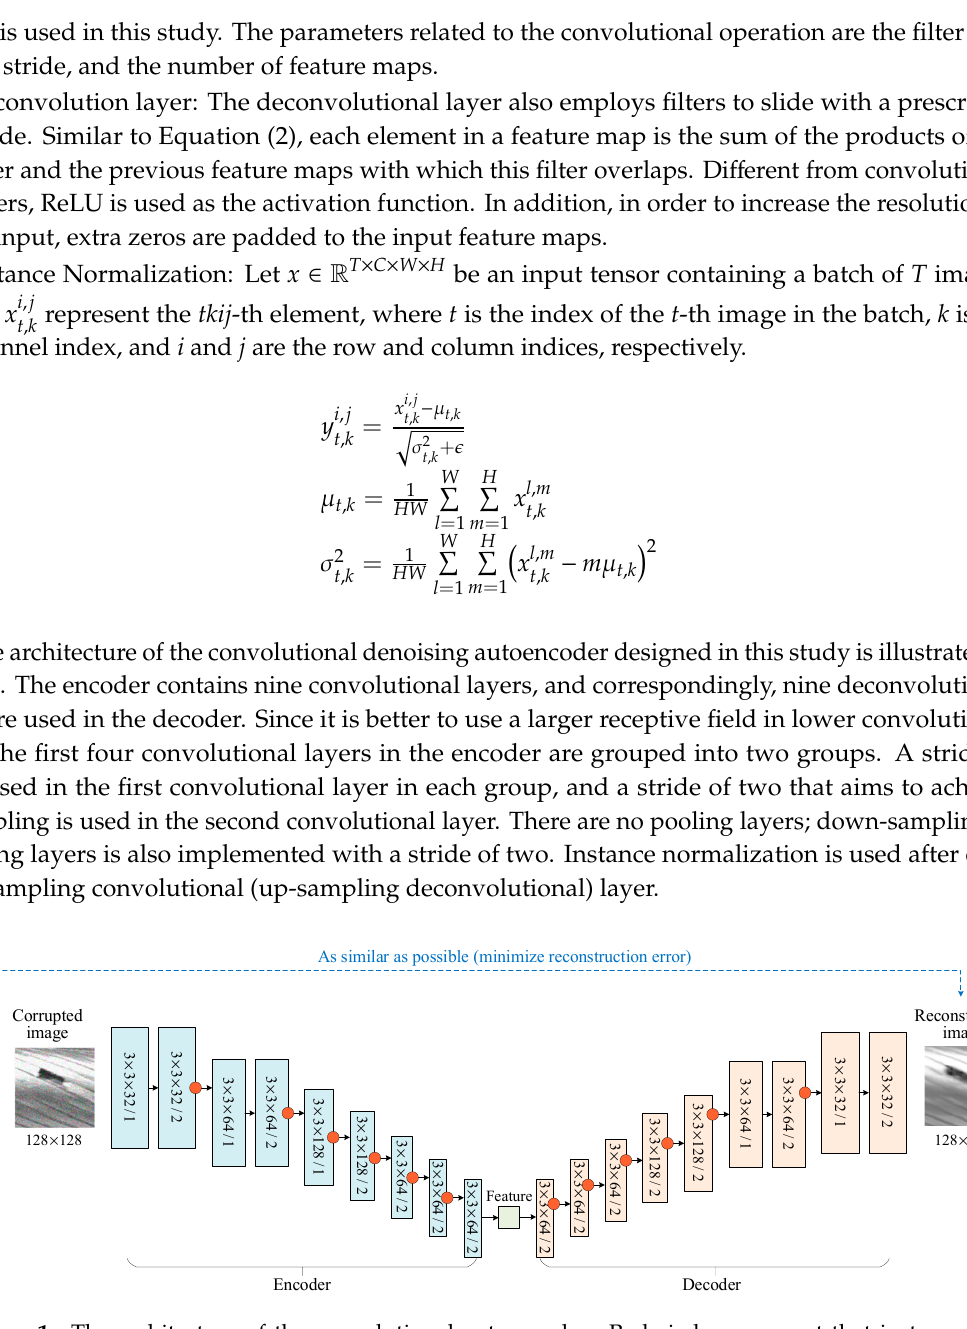
Figure 1. The architecture of the convolutional autoencoder. Red circles represent that instance normalization is used after convolution.